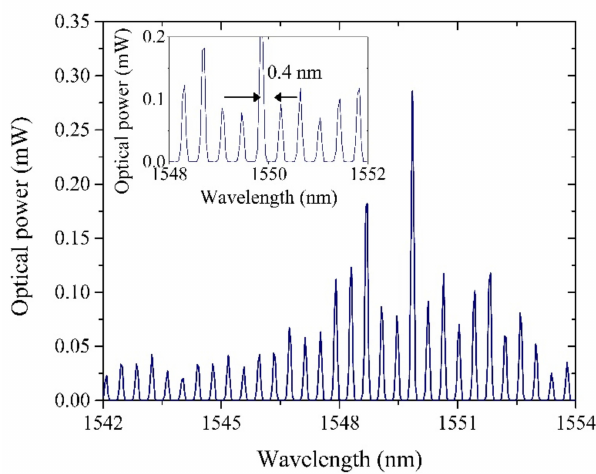
Figure 3. Optical spectrum corresponding to the MLD